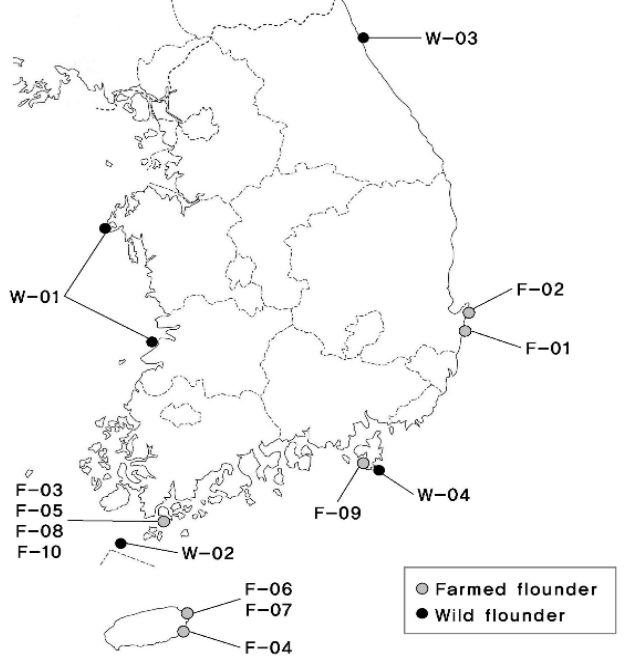
Figure 1. South Korea map showing the collecting locations of wild and farmed populations of olive flounder ( Paralichthys olivaceus ).